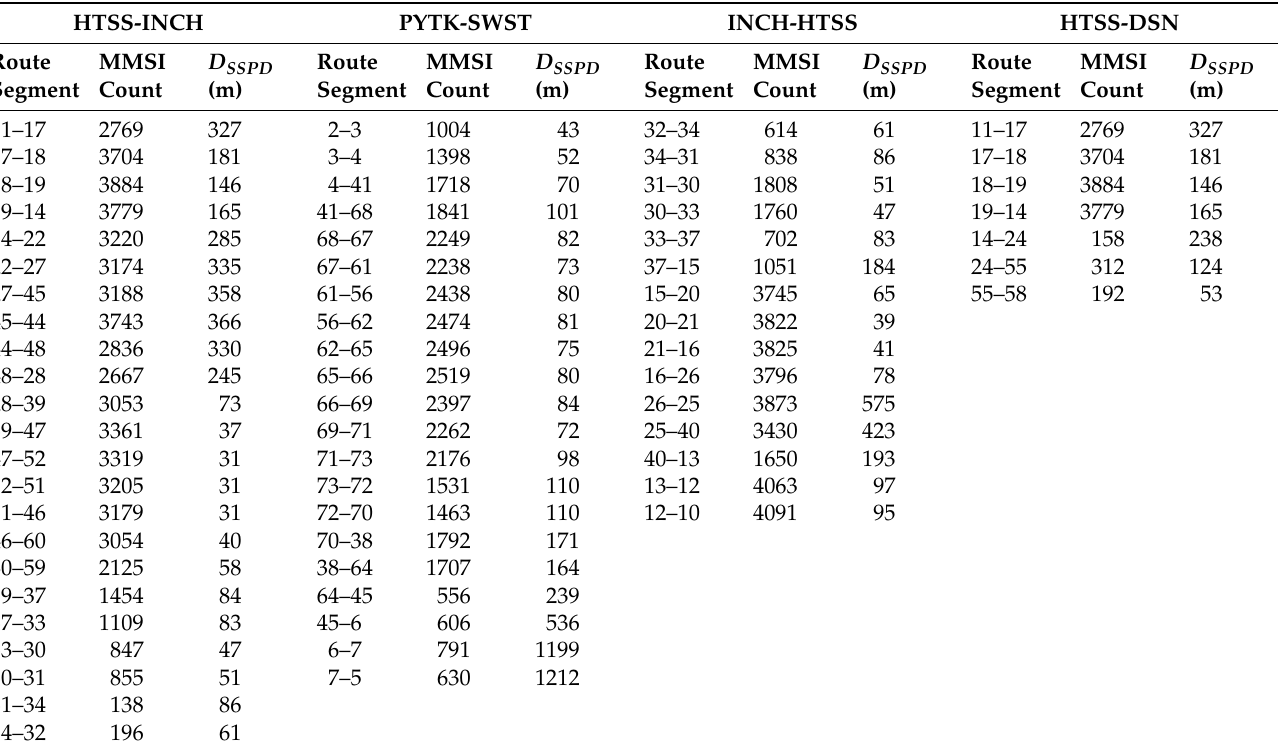
Table 4. Comparison of the sample routes from the maritime traffic network with the AIS